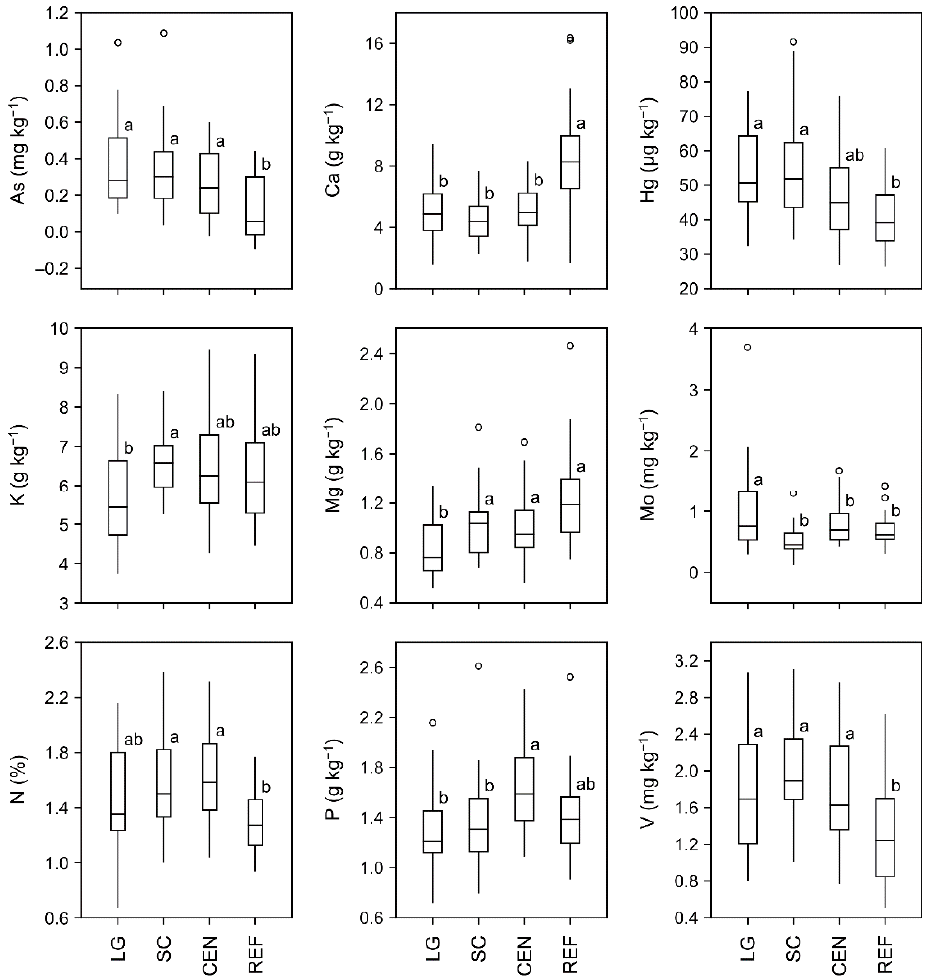
Figure 4. The concentration of major elements and trace elements (those measured only in 2015) in moss in the four studied regions of Poland (Co was omitted because it did not vary significantly between regions). Together with medians, quartiles, non-outlier range, and outliers (without extreme outliers) are shown. Boxplots marked with different letters significantly differ from each other by Tukey's test (P < 0.05).